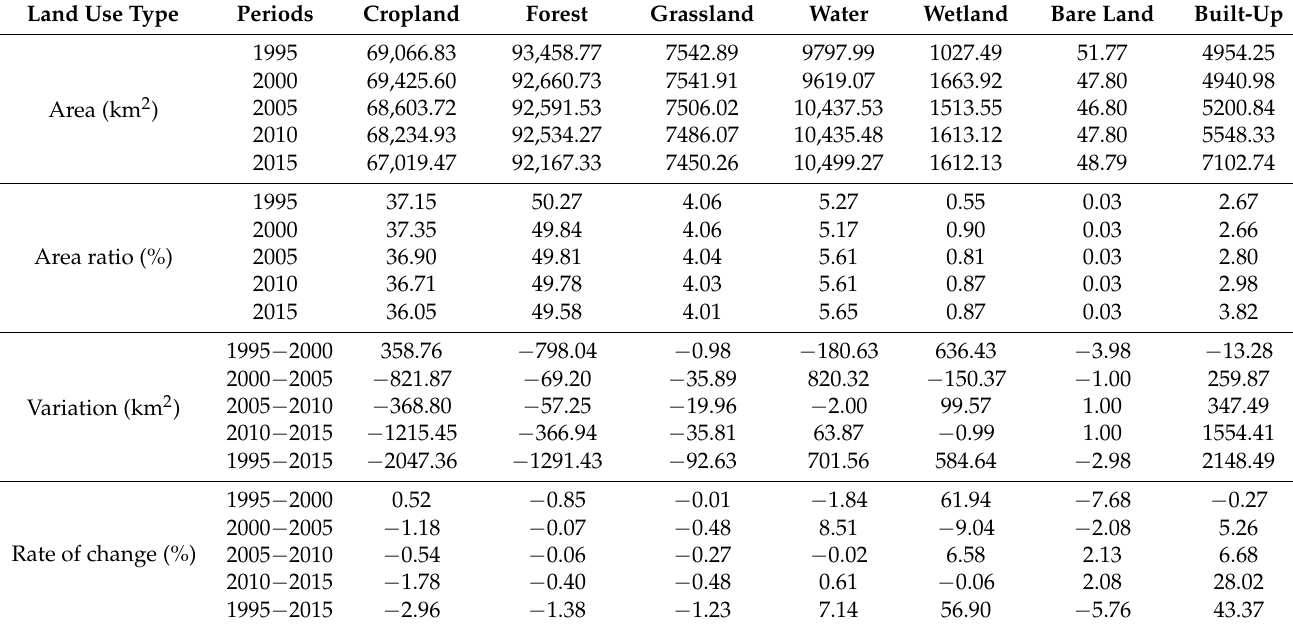
Table 2. Changes in the area of each category from 1995 to